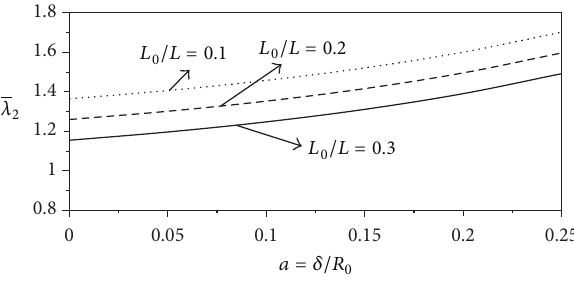
Figure 18: Variations of flow resistance 𝜆 2 with stenosis height 𝛿/𝑅 0 for different values of stenosis length 𝐿 0 /𝐿